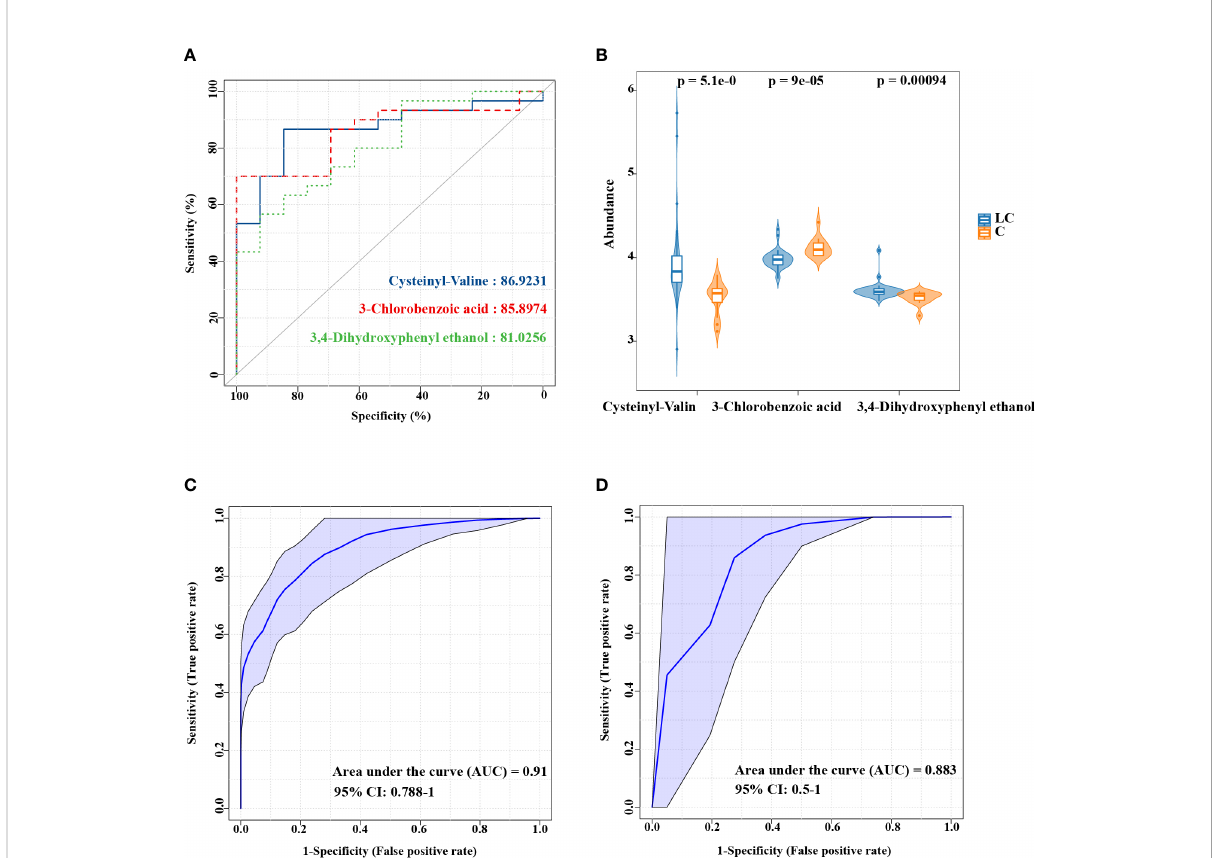
FIGURE 4 ROC curve analysis of the candidate biomarkers for LC. (A) Individual ROC curves and peak areas for Cysteinyl-Valine, 3-Chlorobenzoic acid and 3,4-Dihydroxyphenyl ethanol. (B) The differences in the abundance of three metabolic biomarkers between two groups. (C) ROC analysis based on the combination of three metabolites. (D) ROC analysis for the combination of 9 species screened by